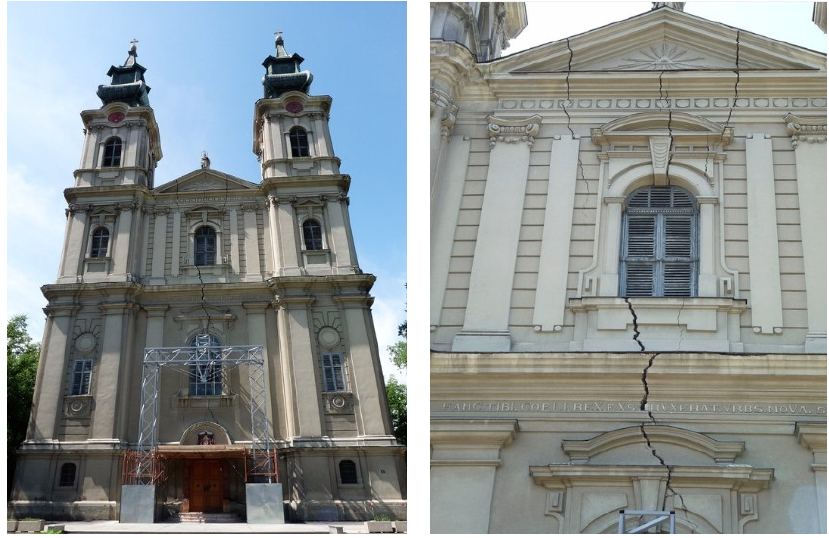
Figure 2. ( Left ) Cracks in the front facade wall; ( Right ) Crack details on the upper window.